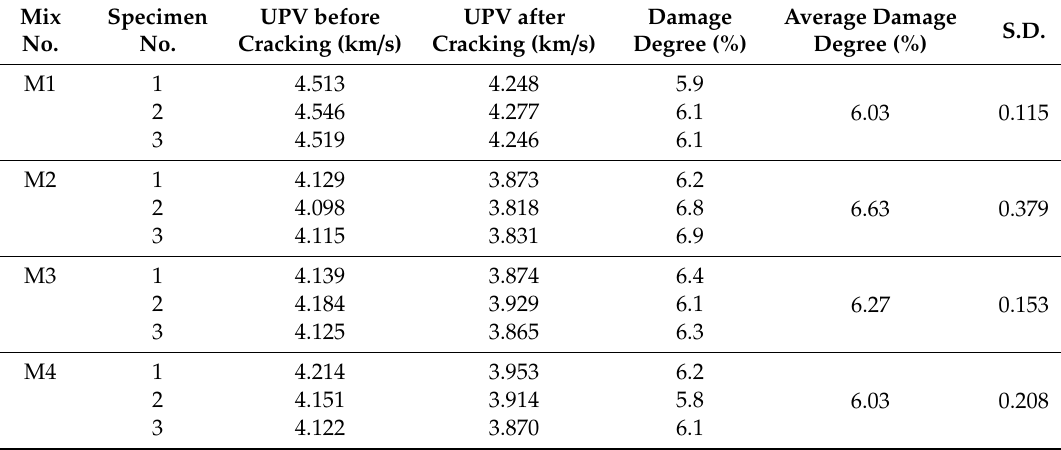
Table 7. UPV values to define damage